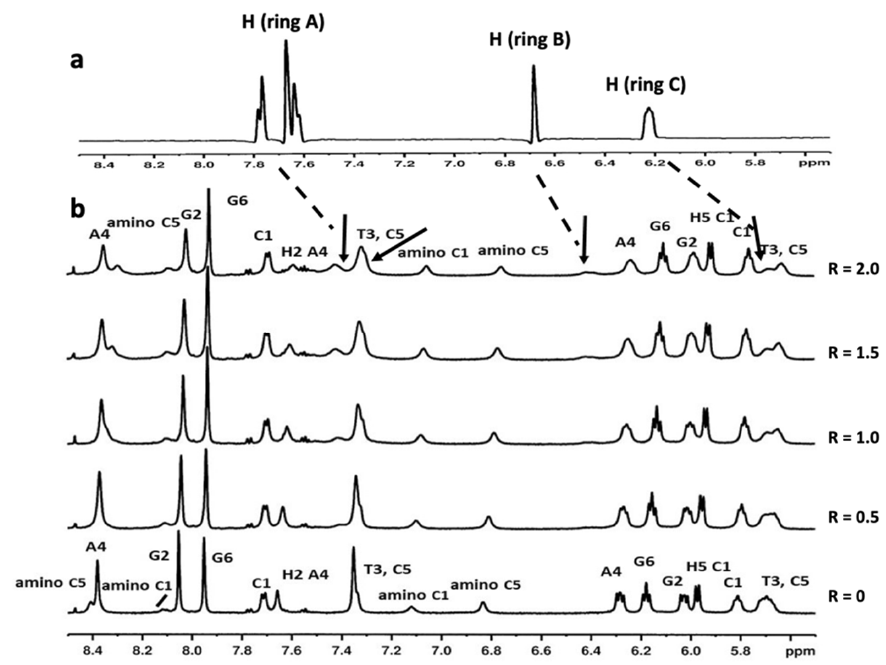
Figure 3. ( a ) Selected 1 H proton region of compound 9 at 15 °C in H 2 O/D 2 O (9:1), 100 mM NaCl and 10 mM sodium phosphate buffer (pH 7.0); ( b ) aromatic and anomeric proton region of the 1 H NMR titration spectra of 5 ′ -d(CGTACG) 2 -3 ′ with compound 9 at 15 °C in H 2 O/D 2 O (9:1), 100 mM NaCl and 10 mM sodium phosphate buffer (pH 7.0), at different ratios R = [ 9 ]/[DNA]. The arrows indicate the broad proton signals of compound 9.